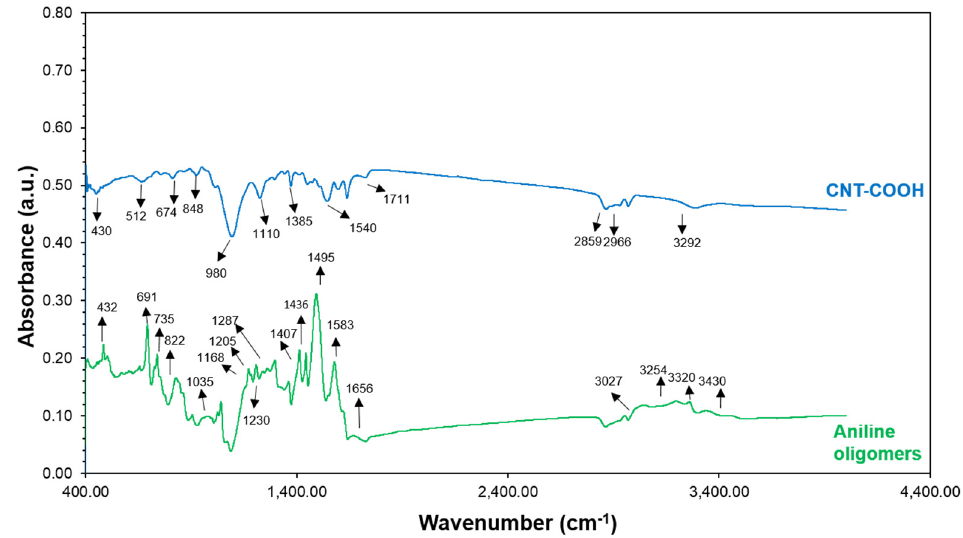
Figure 4. FTIR of carboxylated MWCNT (blue) and aniline oligomers (green).